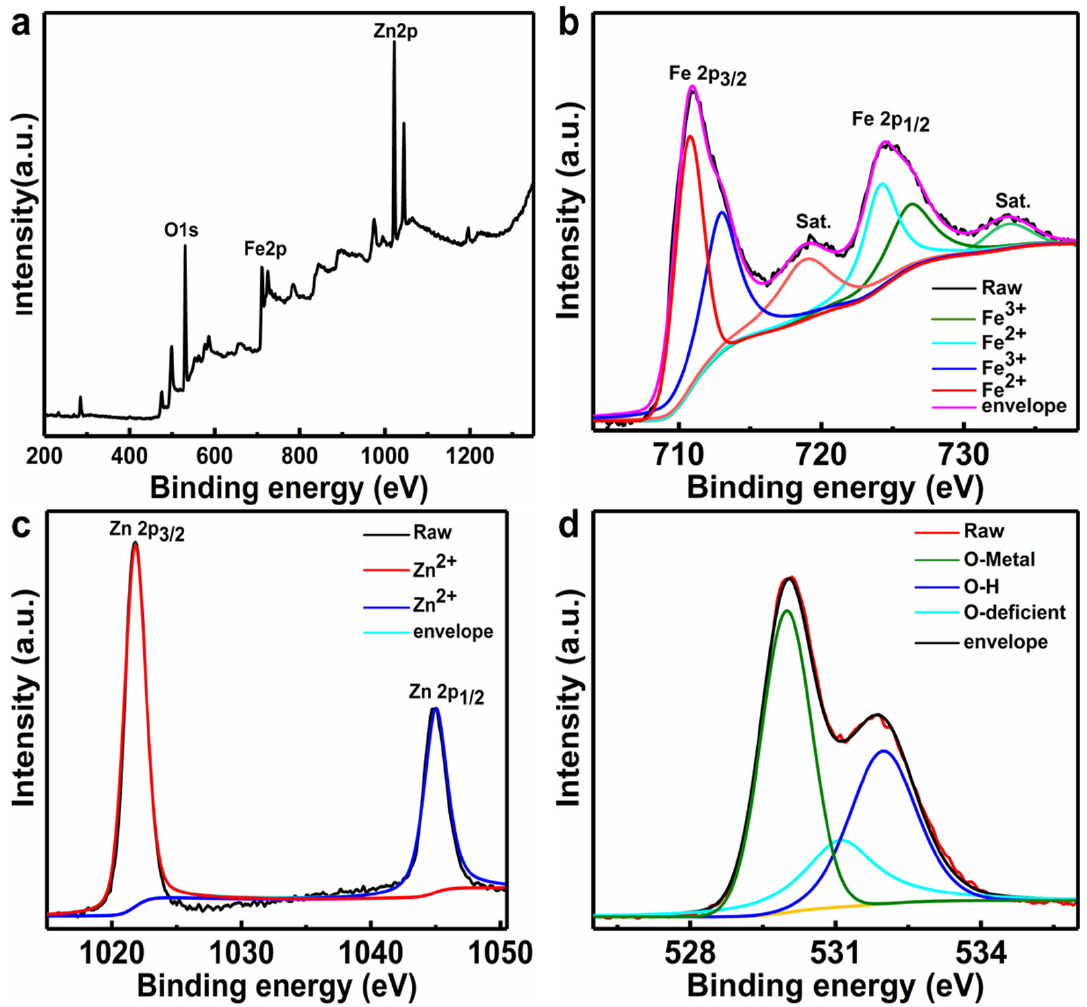
Figure 2. XPS spectra of the ZnO/Fe 2 O 3 NFs: ( a ) survey spectrum, ( b ) Fe 2p, ( c ) Zn 2p, and ( d ) O 1s.